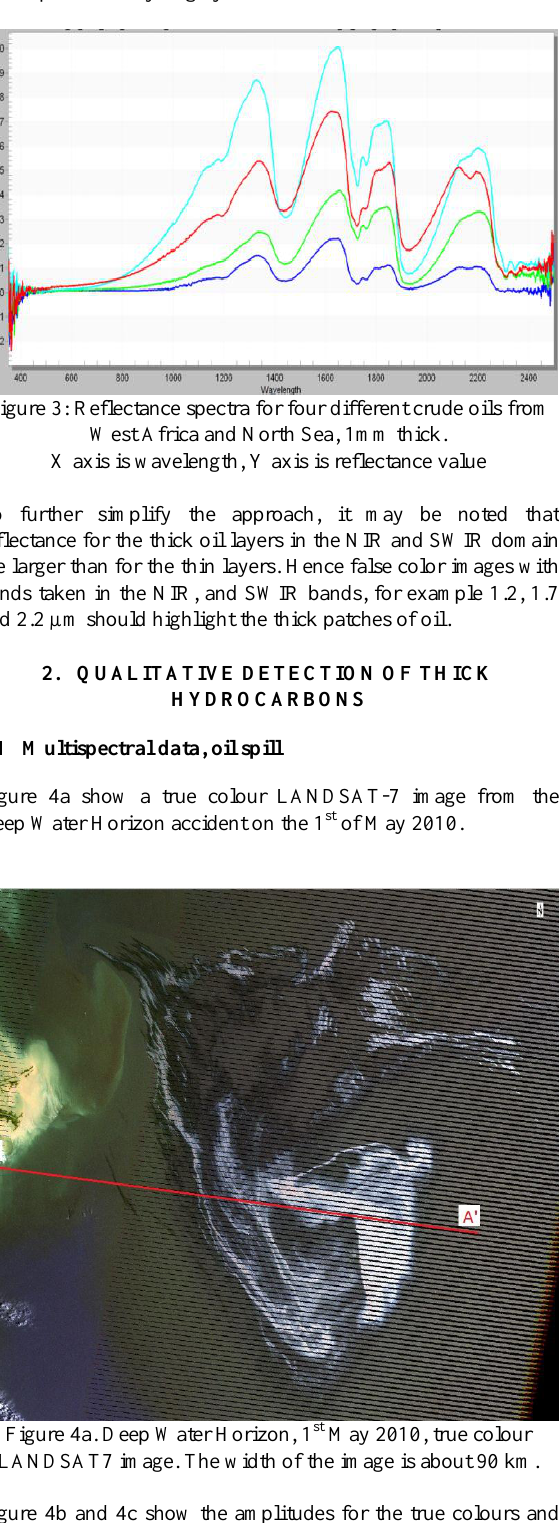
Figure 1. Laboratory spectra of oil emulsion from the Deepwater Horizon oil spill. From Clark, 2010